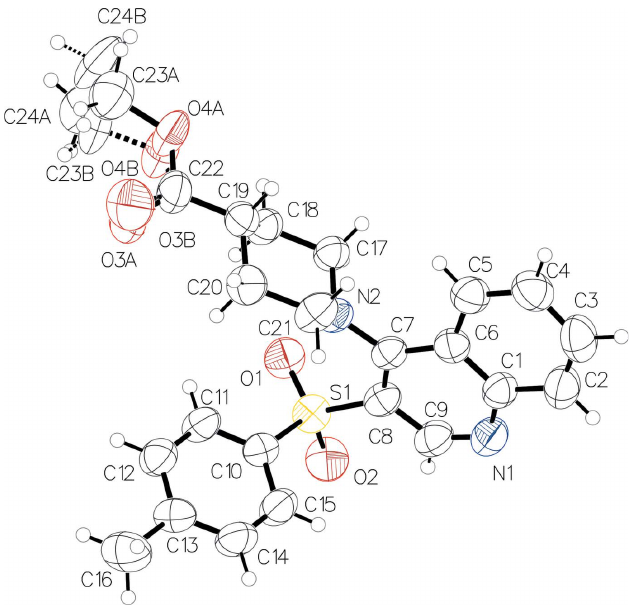
Figure 1 Molecular structure of the title compound. Displacement ellipsoids are shown at the 50% probability